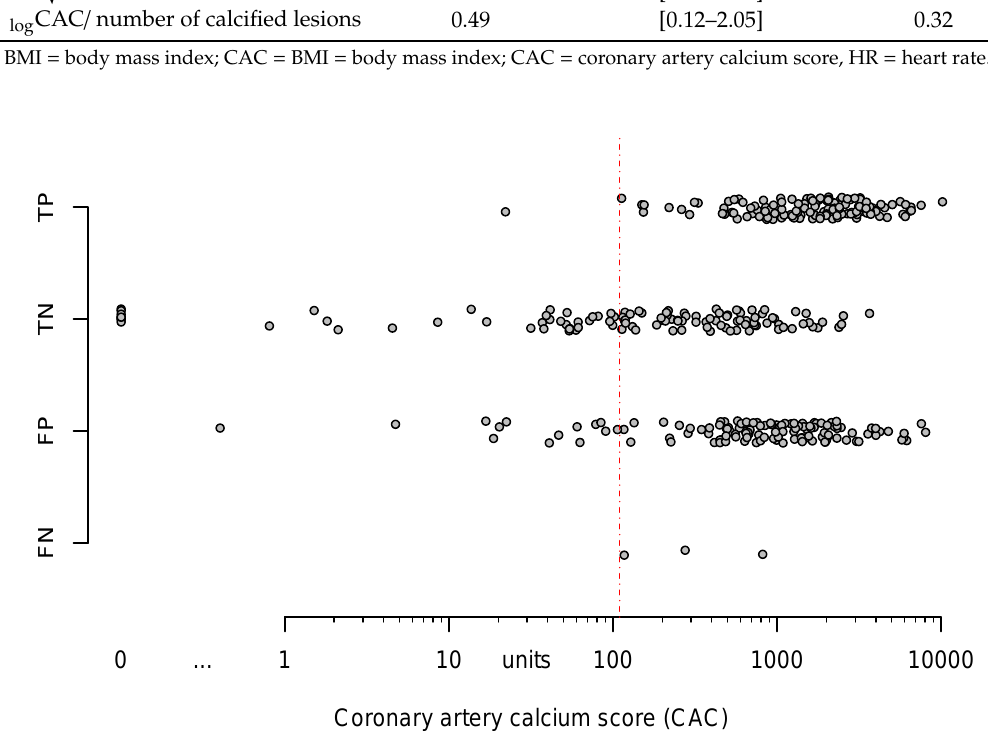
Figure 2. Dot-plot of patient’s CAC and their classification according to cCTA against invasive coronary angiography with QCA. Note the vast overlap of true negative and false positive results in relationship to CAC. The threshold (red dashed line) drawn at a CAC of 110 would exclude all false negative results as well as most true negative results. CAC = coronary artery calcium score, FN = false negative, FP = false positive, TN = true negative, TP = true positive, QCA = quantitative coronary